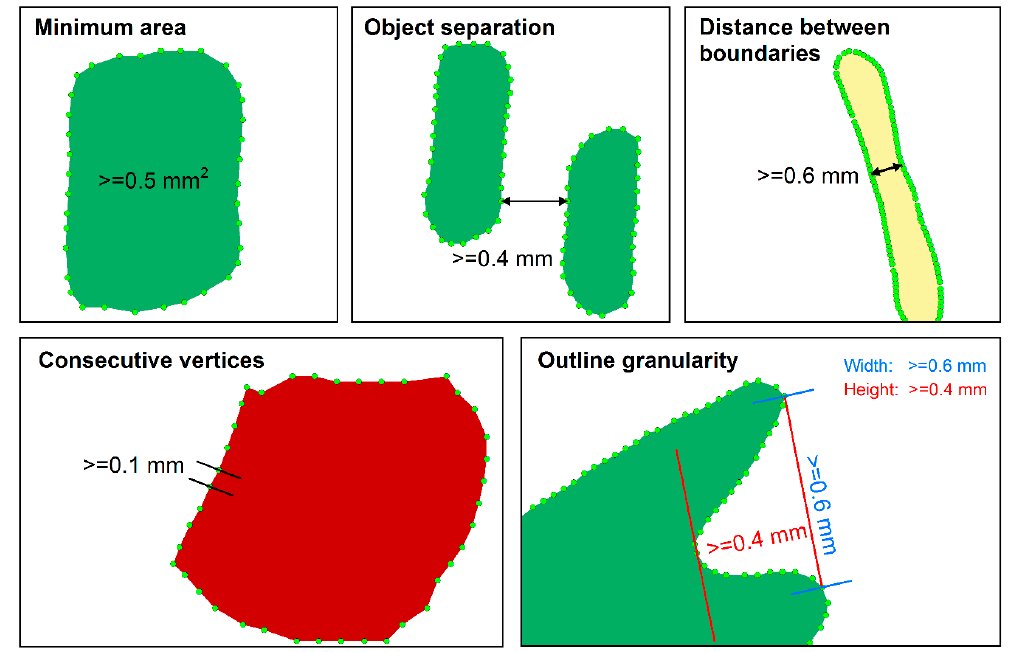
Figure 3. Graphical representation of the size constraints.